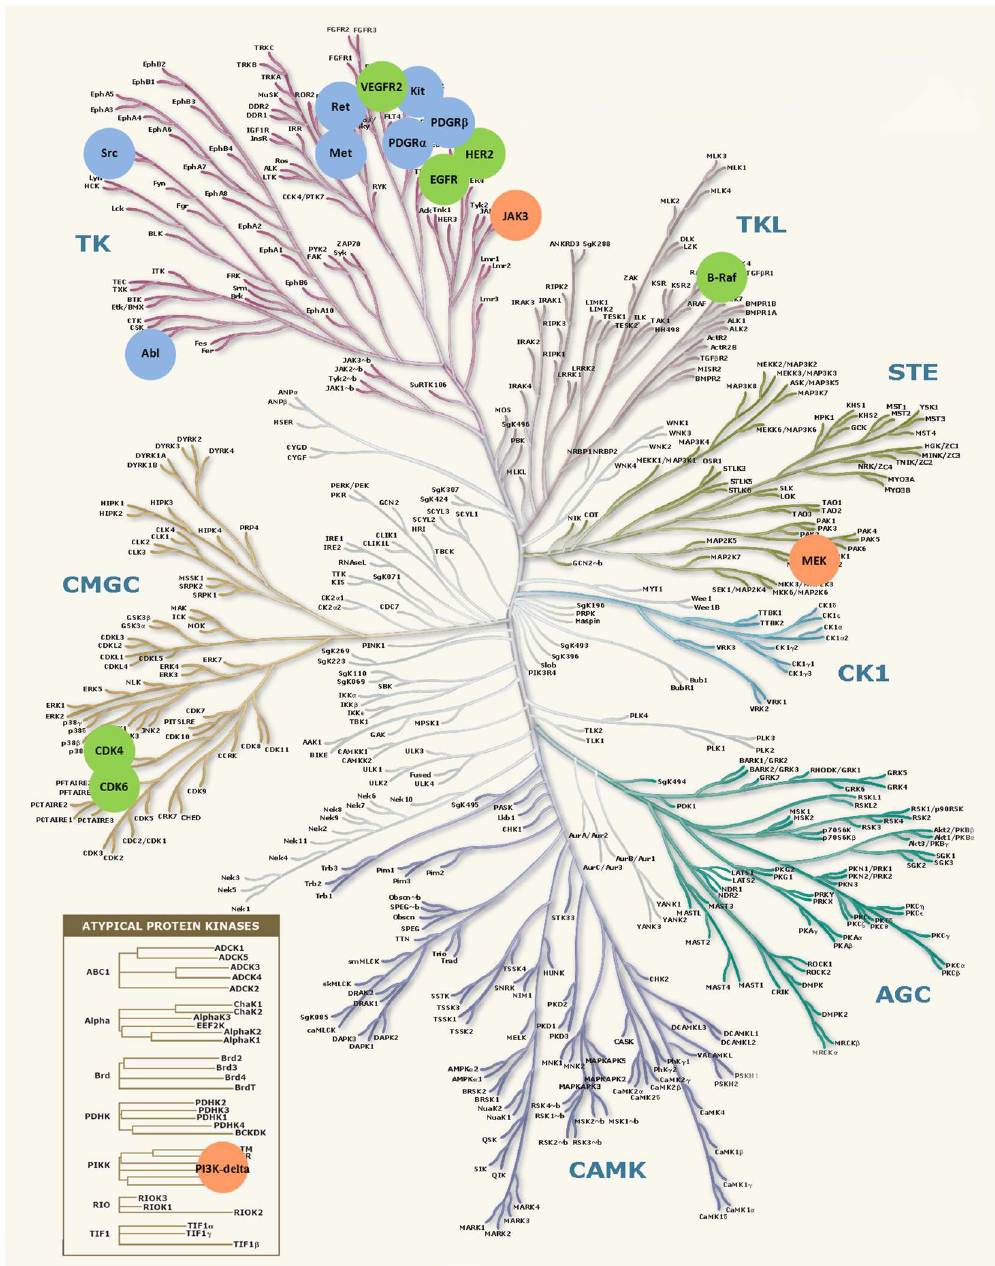
Fig 3. Targets of approved multi-target drugs and combination products in the phylogenetic tree of the human kinome adapted from Manning and colleagues [7]. The targets of both multi-target drugs and combination products were highlighted by green circle, while the targets of either multi-targetdrugs or combination products were highlighted by blue and orangecircle respectively.